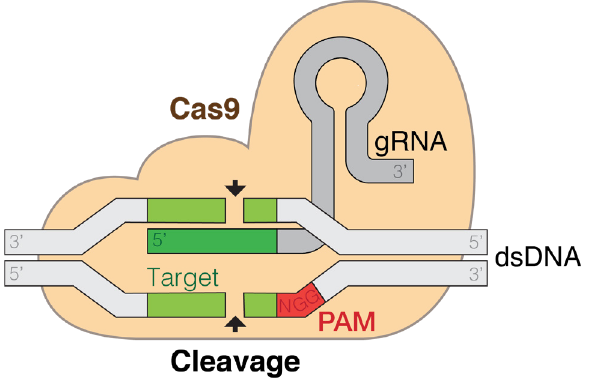
Figure 1 : CRISPR/Cas9 targeting and cleavage mechanism. Guide RNA (“gRNA”) pairs with one strand of DNA in a region (highlighted in green) of sequence containing the cleavage site. The Cas9 endonuclease (yellow) binds to the RNA-DNA complex and cleaves both strands of DNA at a position indicated by the arrows, creating a double-strand break. Image created by Marius Walter and licensed under Wikimedia Creative Commons [https://commons.wikimedia.